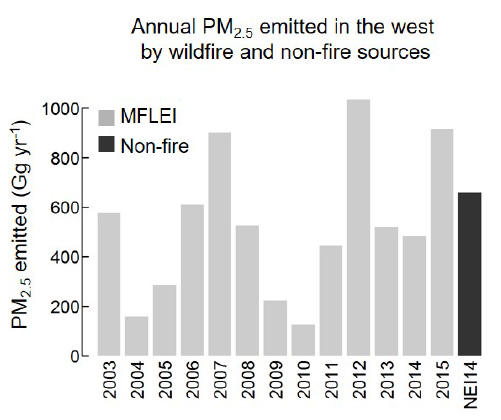
Figure 18. Annual PM 2 . 5 emitted in the west.